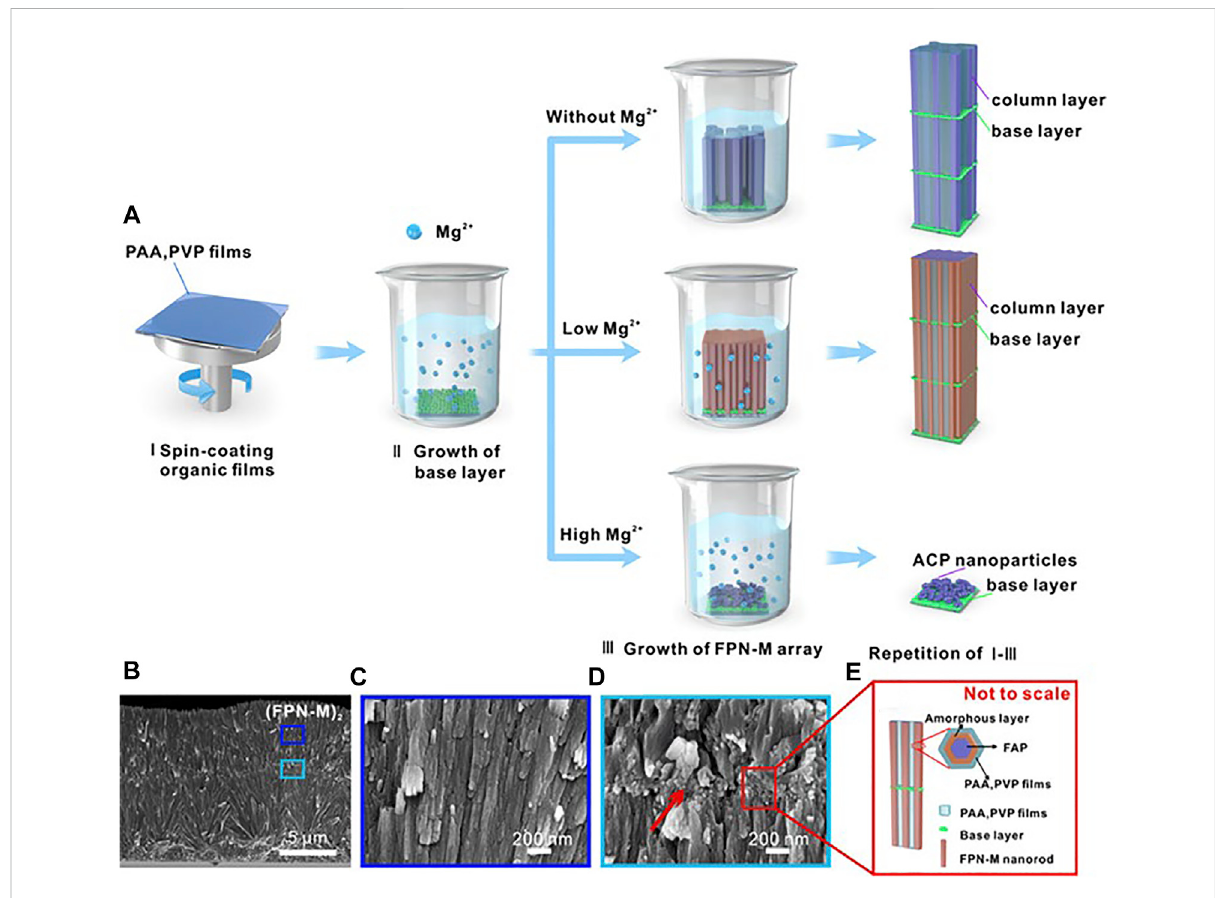
FIGURE 3 (A) TheschematicdiagramofthesyntheticmultilayerFAP/polymernanocompositecontrolledbyMg 2+ . (B) — (C) Cross-sectionalSEMimagesof (FPN-M) 2 with corresponding details. (D) Granular interlaminar base layer (indicated by red arrows). (E) Interlayer structure and amorphous- reinforced architecture schematic diagram. Reprinted with permission from [ (Li Y. et al., 2021) ]. Copyright © 2021 American Chemical